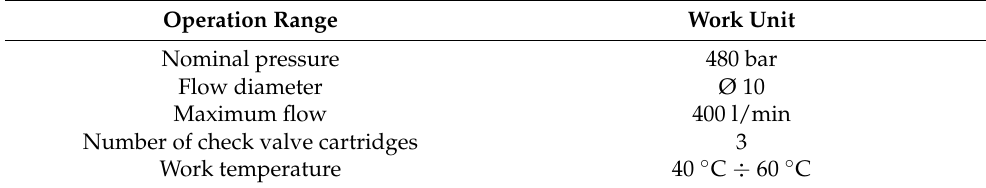
Figure 5. The concept and design of a double block with a recharging function for the powered roof support hydraulic system. Table 1. Technical characteristics of the prototype double